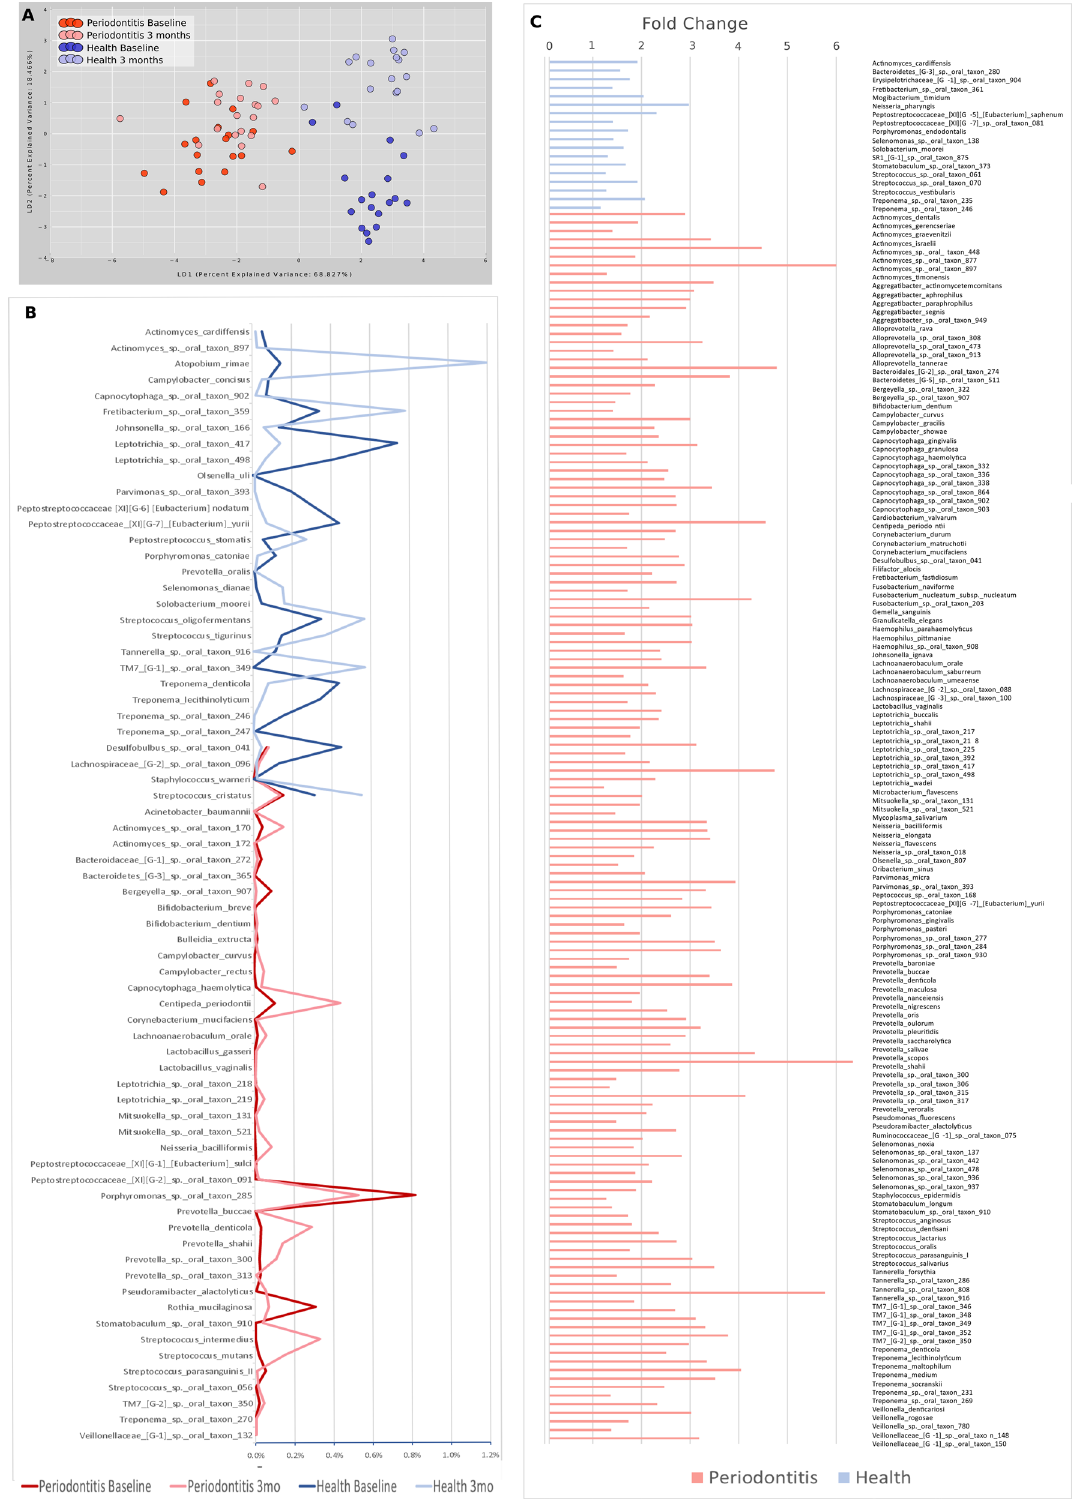
Figure 3. Longitudinal evaluation of the microbiome at baseline and three months after plaque control. ( A ) β-diversity, LDA of Morisita-Horn Dissimilarity Index. ( B ) Change in the relative abundance of species over time ( p < 0.05, FDR-adjusted Wald Test, DESeq2). ( C ) Species differentially abundant between periodontitis and health groups after plaque control. The length of the bar indicates the fold-difference between groups. The pink bars represent the bacteria more abundant in children from periodontitis parents, the blue bars the bacteria more abundant in children from healthy parents ( p < 0.05, FDR-adjusted Wald Test,